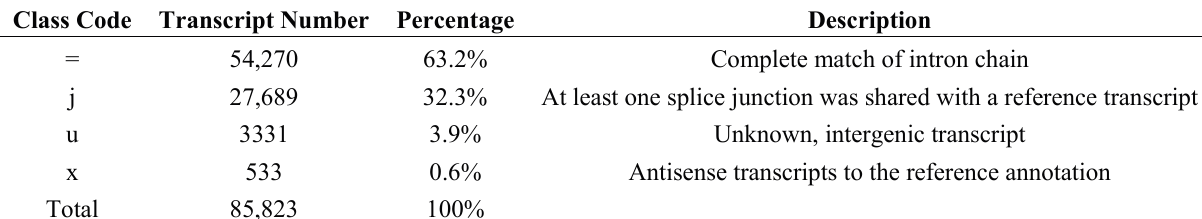
Table 1. Categories of transcriptome